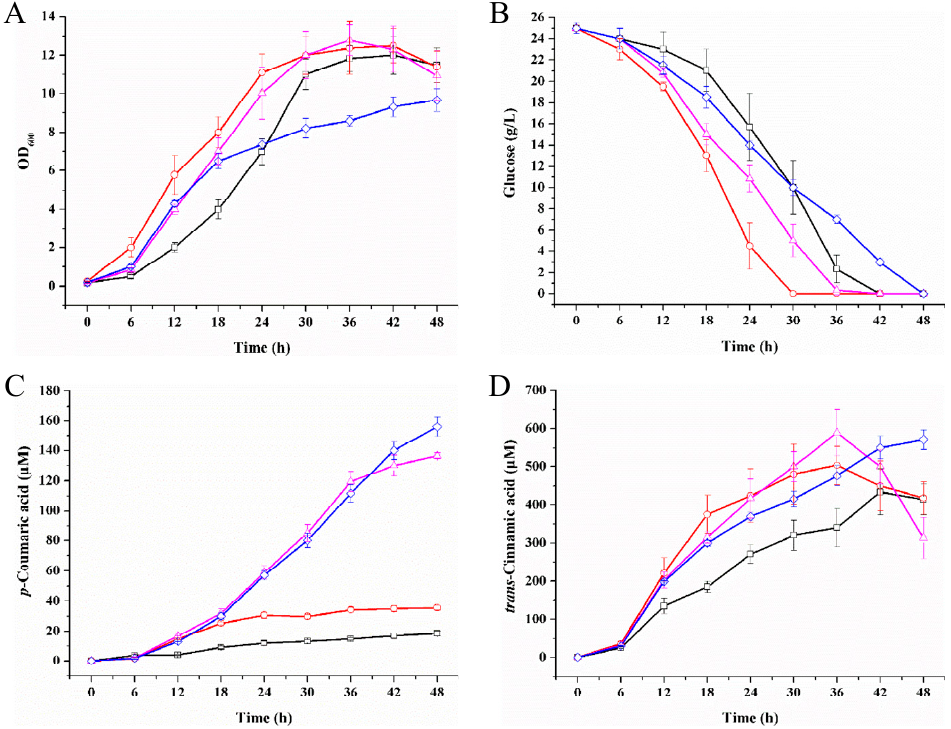
Figure 6. Regulation of intracellular NADPH to improve the p -coumaric acid production. ( A ) cell growth; ( B ) glucose utilization; ( C ) p -coumaric acid biosynthesis; ( D ) trans -cinnamic acid accumulation. The p -coumaric acid producers were Ec/ Lau C4H- Ath PAL-sRNA (black square), Ec/ Lau C4H- Ath PAL-anti(sthA) (red circle), Ec/ Lau C4H- Ath PAL-PntAB (magenta triangle), and Ec/ Lau C4H- Ath PAL-PntAB-anti(sthA) (blue diamond). The error bars represent the standard error of the mean from three independent experiments of each strain.